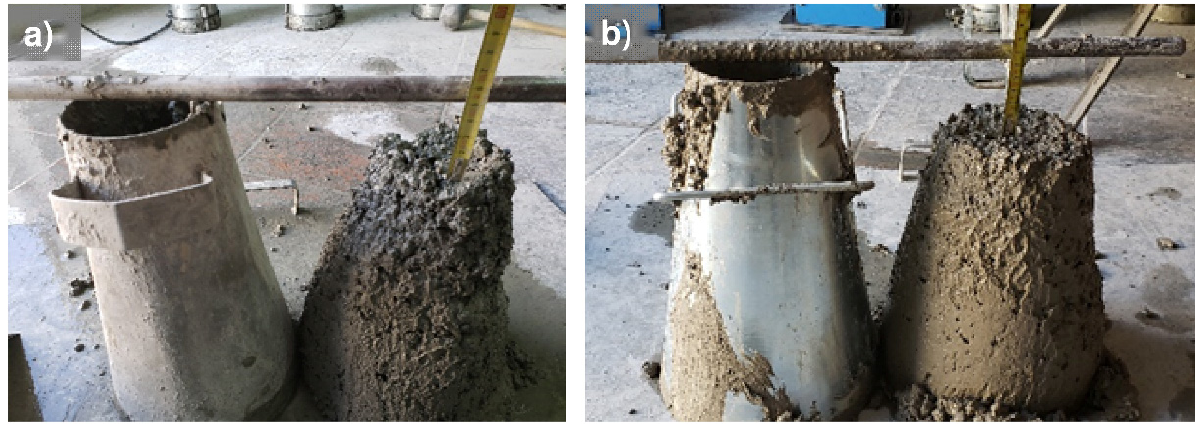
Figure 4. Concrete slump test: ( a ) Concrete with 100% NA (M1) and ( b ) Concrete with 50% fMRA and cMRA (M9).